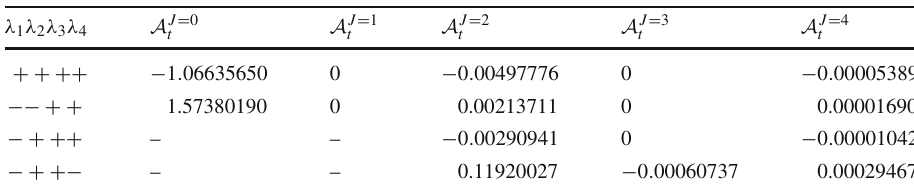
of A J t ,λ 1 λ 2 λ 3 λ